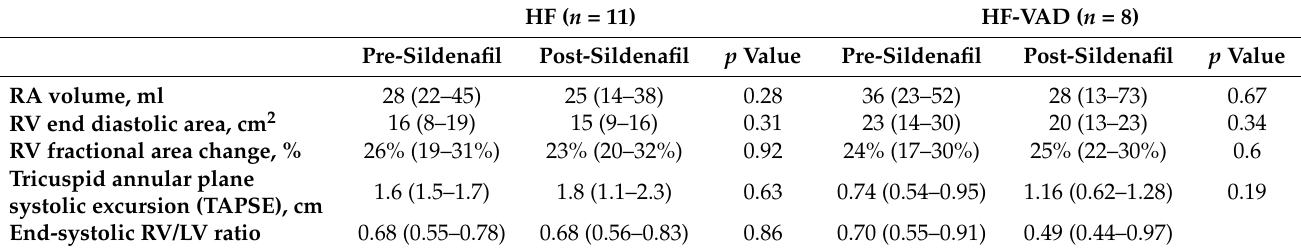
Table 2. 2D echo parameters in the HF and HF-VAD groups before and after sildenafil therapy. The values are expressed as medians (interquartile ranges) unless otherwise